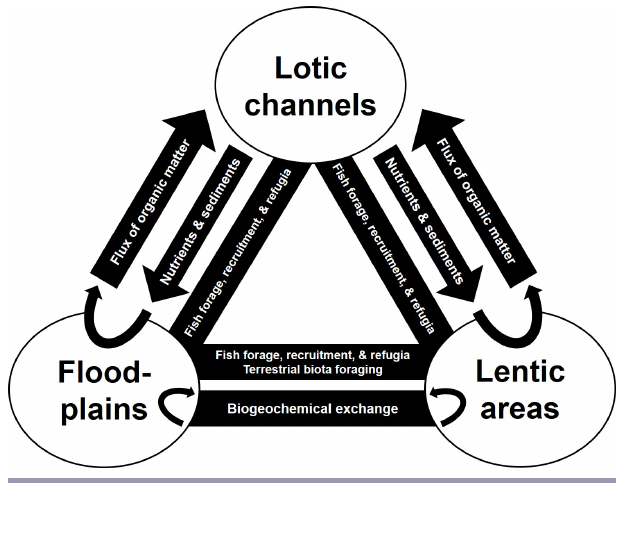
Fig. 3 . The Upper Mississippi River can be decomposed into three subsystems: lotic channels, lentic backwater lakes and impounded areas, and floodplains. Connectivity and exchange between subsystems is critical to the structure and function of large floodplain rivers. Curved arrows represent biogeochemical processing.